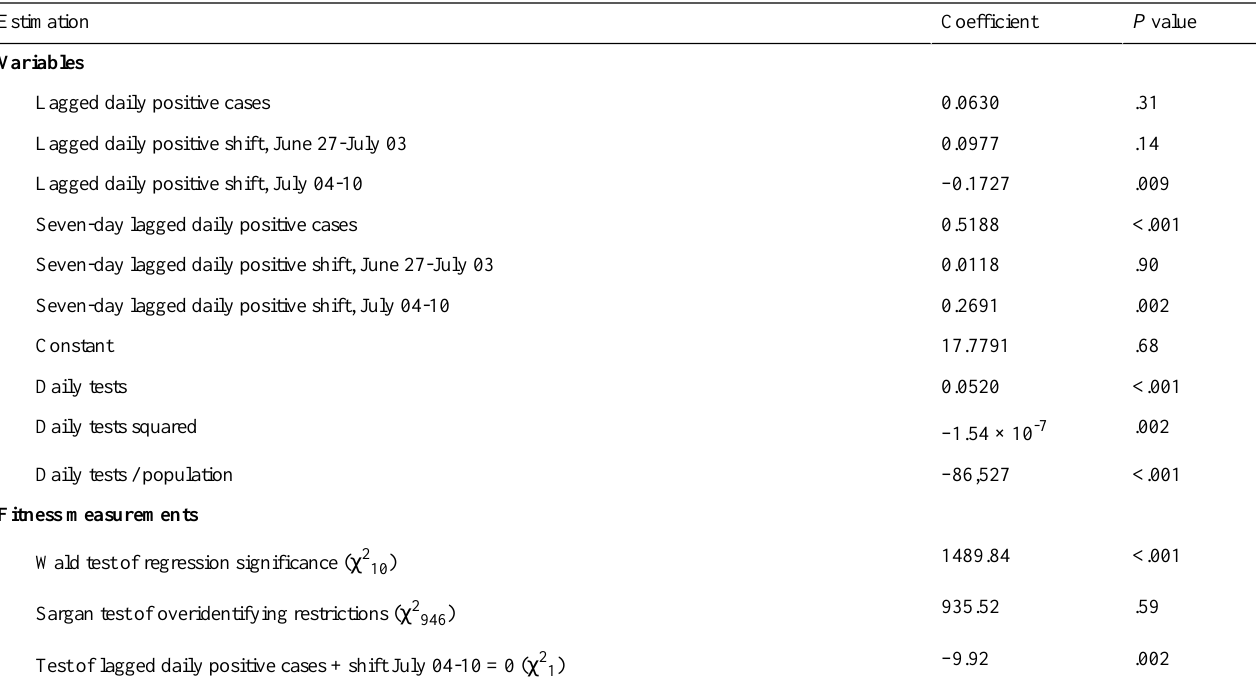
Table 1. Arellano-Bond dynamic panel data modeling of the number of daily infections by state from March 20 to July 10, 2020.